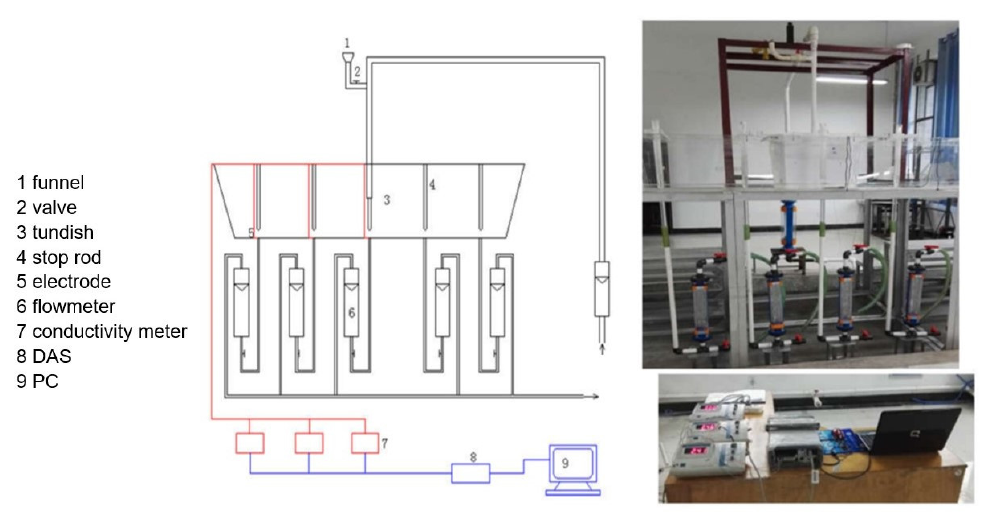
Figure 4. Schematic diagram and plexiglass model for water model of tundish.